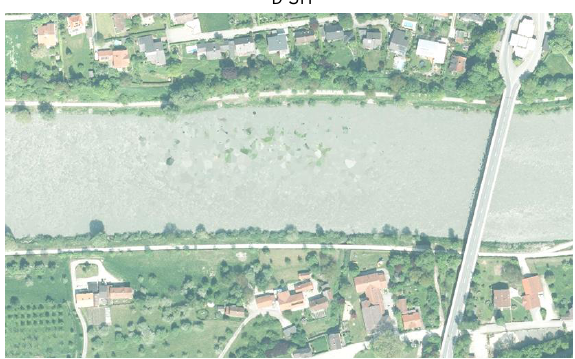
Figure 8. Error caused by DSM-noise in water